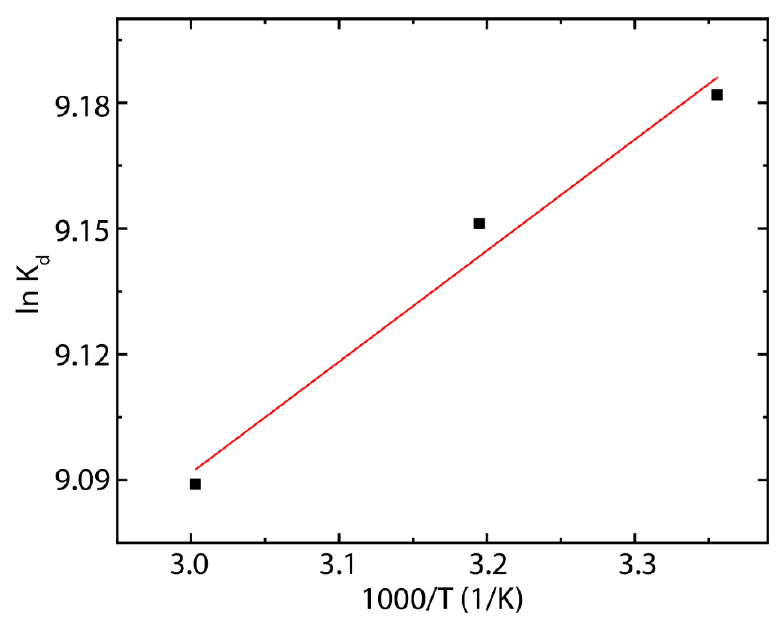
Figure 8. Van’t Hoff plot for the adsorption of MB on rGO. Figure 8. Van’t Ho ff plot for the adsorption of MB on